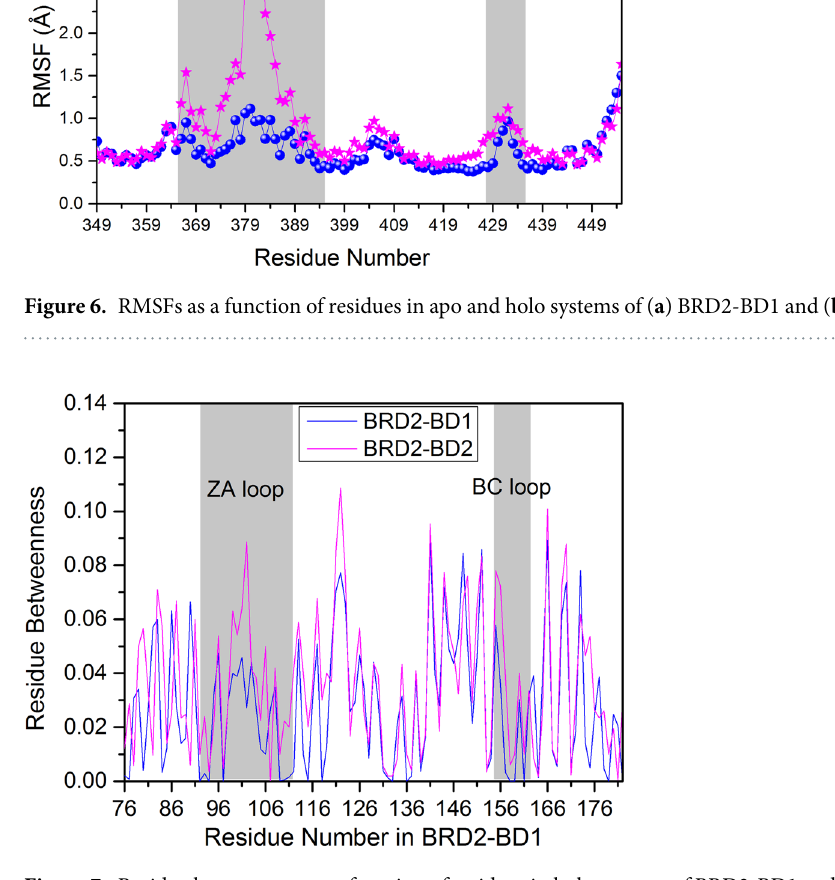
previously 21 . In our study, compared to BRD2-BD1 system, -O(CH 2 ) 2 -OH of RVX-208 is more prone to point out to the solvent in BRD2-BD2 system. In addition, RVX-297, a compound found by Hansen et al . 40 , differs from RVX-208 only with the -O(CH 2 ) 2 -OH replaced by -O(CH 2 ) 2 -pyrrolidine. However, BD2-selectivity of the former increases by more than two times, further emphasizing the importance of hydrophilic groups in the structure of